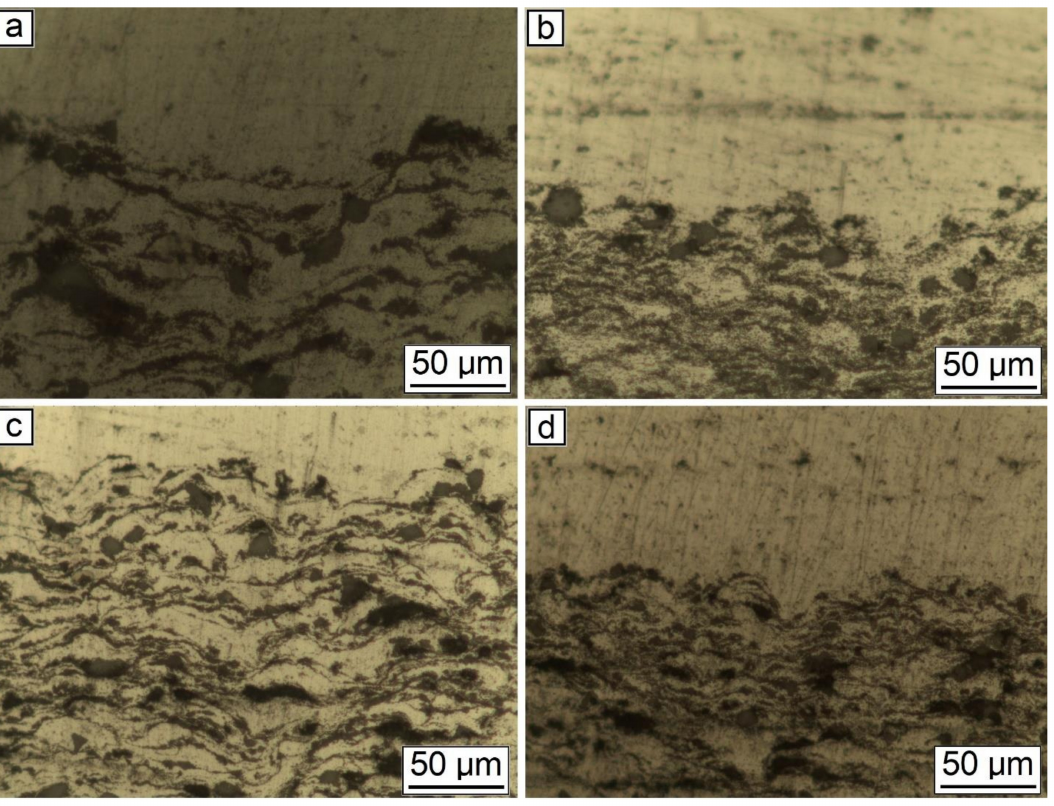
Figure 6. Microstructure of the synthesized samples: ( a ) 30% Al + 70% Al 2 O 3 ; ( b ) 29.5% Al + 70% Al 2 O 3 + 0.5% CNF; ( c ) 29% Al + 70% Al 2 O 3 + 1.0% CNF; ( d ) 28.5% Al + 70% Al 2 O 3 + 1.5%